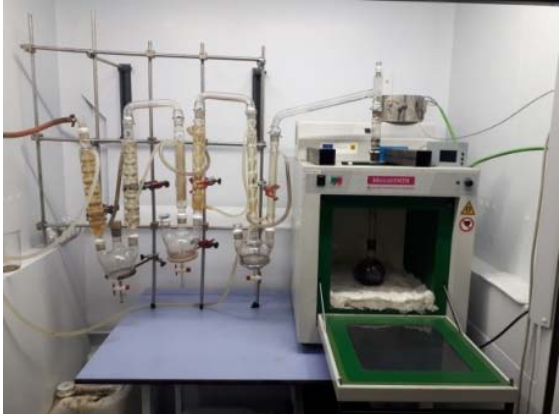
Figure 1. Pyrolysis prototype